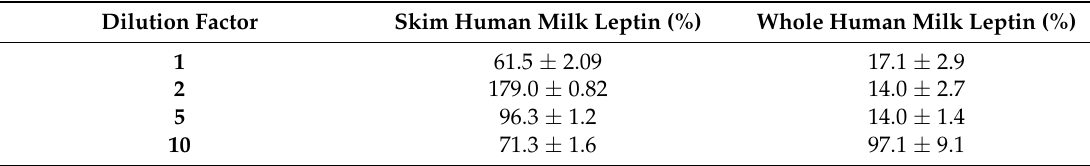
Table 2. Recovery percentages for each dilution factor for skim and whole human milk leptin measurement. Dilution Factor Skim Human Milk Leptin (%) Whole Human Milk Leptin